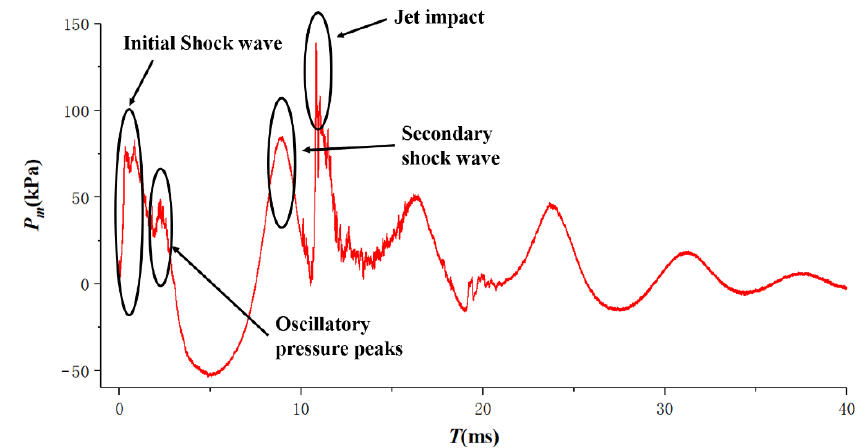
Figure 7. The pressure in the center point of the aluminum plate. Initially, when the compressed gas was released into water, an initial shock wave was generated immediately. The directional fast air jet pushes the water impacting on the wall continuously and rapidly, forming a transient vortex in front of the wall [38,39]. Un- der this water impact, several oscillatory pressure peaks were observed right after the initial shockwave, whose duration was around 1 – 2 ms. These oscillatory pressure peaks were not observed by previous experiments of spark bubble or underwater explosion bub- ble [40,41], which indicated that the directional fast air jet indeed caused the change of flow field and induced strong additional pressure loads. It is expected that these oscilla- tory pressure peaks would aggravate the damage of ice. Then a ‘ pear- like’ bubble was formed and the induced pressure became stable and declined smoothly until the first bot- tom at 5 ms, when the bubble reached a maximum volume in the first expansion as shown in Figure 6c. One may notice that there was a part of bubble structure directly attached to the plate, which was just a mirrored image of the original bubble due to the reflection of the smooth aluminum plate surface (same for the subsequent pictures). After that, the airgun bubble collapsed under pressure difference, while the induced pressure rose smoothly. In the process of bubble collapse, the lower part of the bubble started to separate from the exhaust port of the airgun and got to involute as shown in Figure 6d. The detailed development process of involute bubble surface was recorded in Appendix A along with the variation of the bubble volume. As a result, an upward jet started to be generated under the combined effects of attraction force of the wall and buoyancy force. Then the bubble reached a minimum volume around 8.85 ms as shown in Figure 6e. At this mo- ment, the secondary shock wave [42] was released as marked in Figure 7. The upward jet moved further but did not penetrate the bubble yet. After the first minimum volume, the bubble started to re-expand and its surface started to become unsmooth distinctly. At around 10.80 ms in Figure 6f, the jet penetrated the bubble and impacted on the surface of